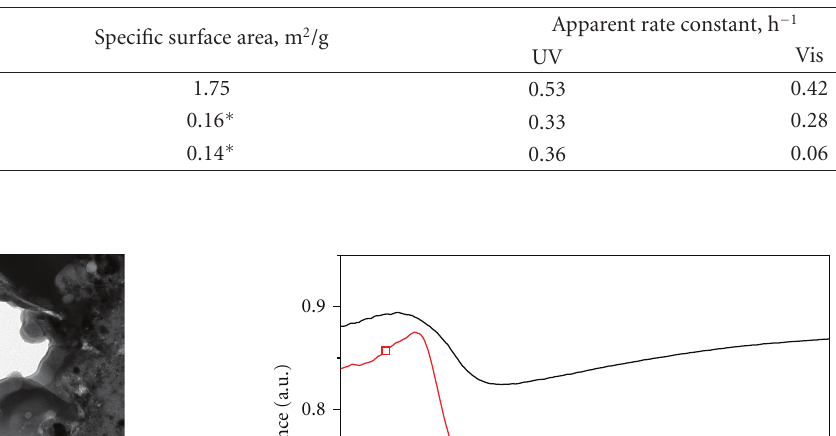
Table 1: Some properties and apparent rate constants of three samples.